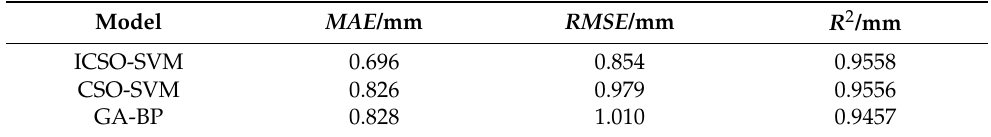
Table 5. Mean absolute error and root mean square error of different dam horizontal displacement prediction models.